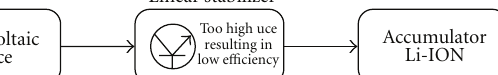
Linear stabilizer